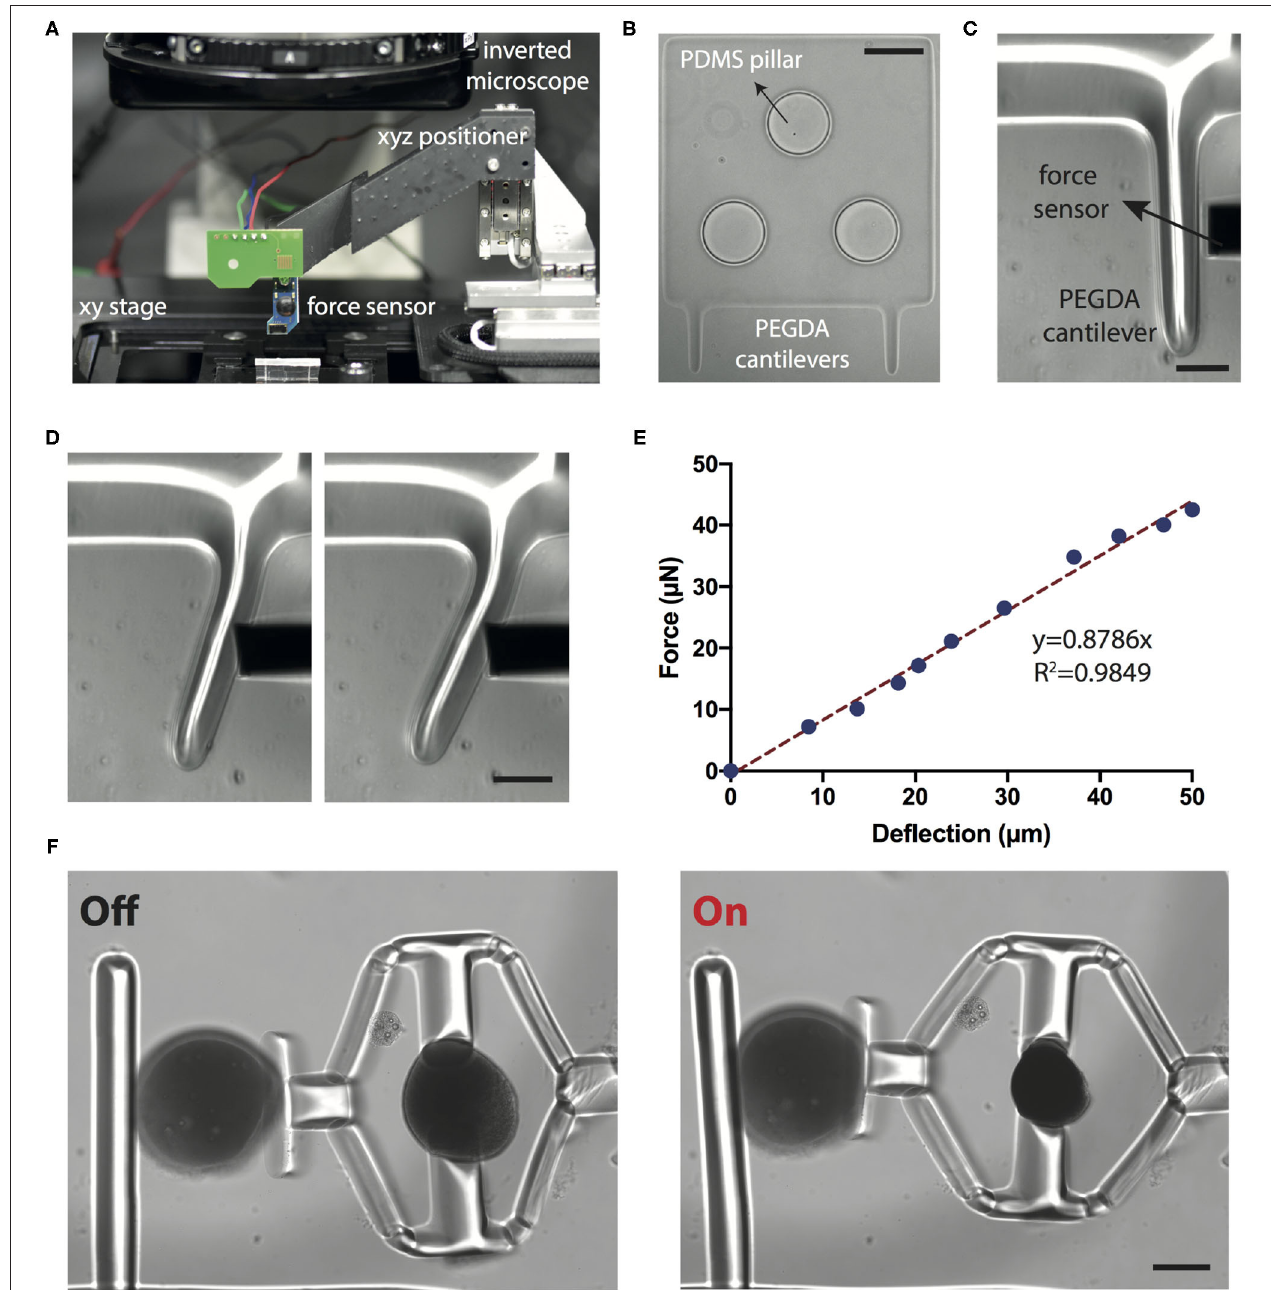
FIGURE 4 | Calibration of the sensing probe. (A) The position of the MEMS force sensor is controlled by a motorized 3-axis micromanipulator while the sample is translated on a plane using the microscope stage. (B) The base of the cantilever beams is polymerized directly around the PDMS micropillars using the digital maskless lithography system. The pillars stabilize the base and keep it stationary during mechanical loading. Scale bar, 100 µ m. (C) Close-up of the cantilever beam and the tip of the sensor. Scale bar, 50 µ m. (D) Snapshots from a representative indentation experiment. Scale bar, 50 µ m. (E) A representative force vs. deflection curve. The slope of the linear fit is used for calculating the bending modulus. (F) Representative images from a compression test for PAAm beads. Scale bar, 100 µ m.